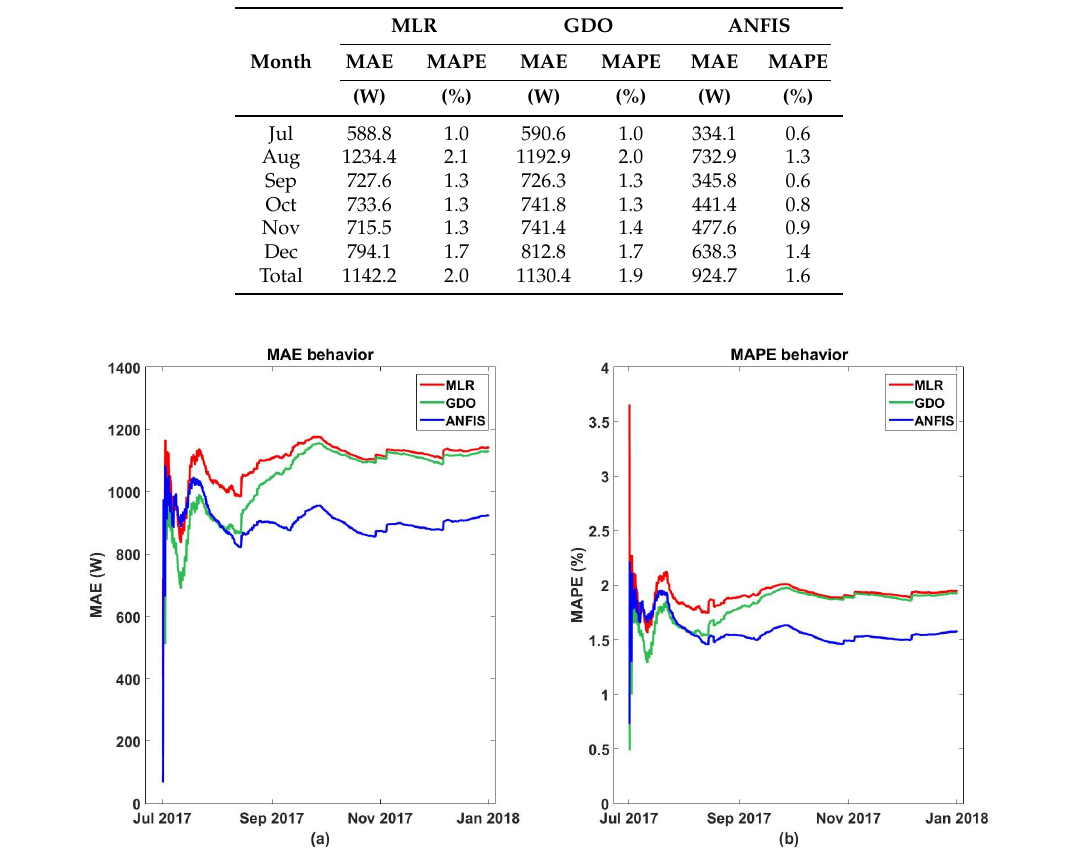
Figure 14. Error behavior comparison between MLR, GDO and ANFIS from MCS: ( a ) MAE behavior; ( b ) MAPE